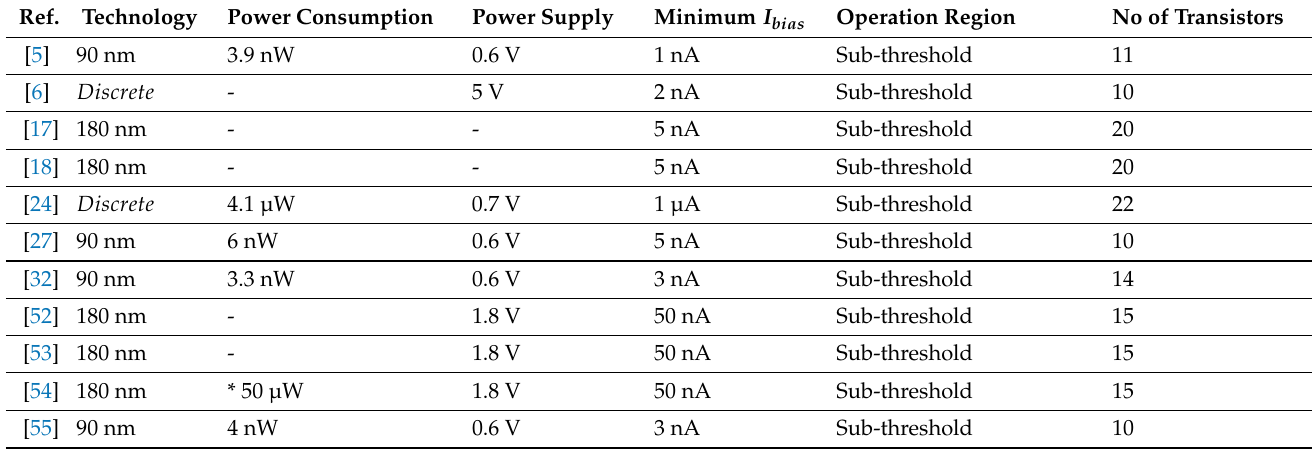
Table 2. Bulk-controlled Gaussian Function Circuits. * For the entire